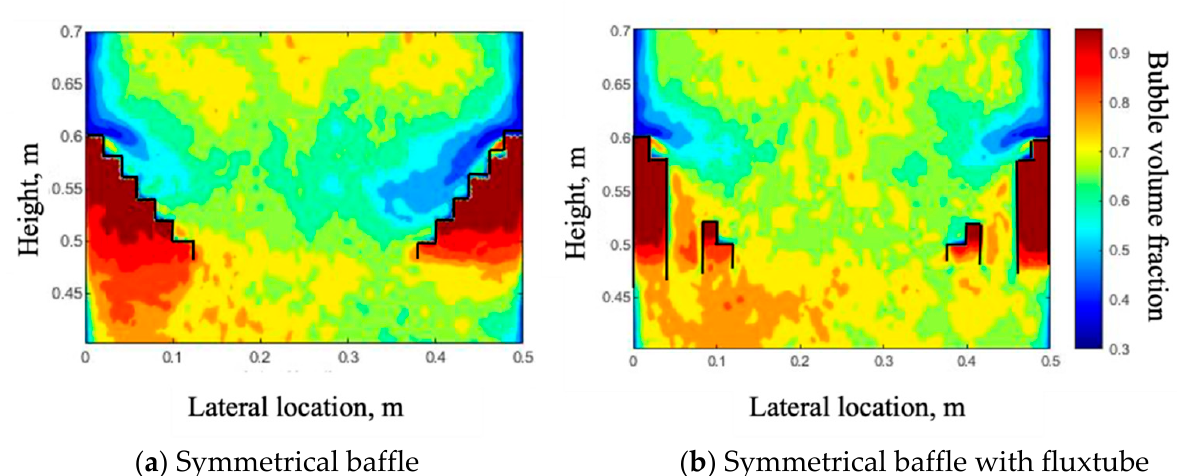
Figure 8. Radial gas bubble distribution profiles at injection level using the symmetrical baffle with and without the fluxtube under the superficial gas velocity of 0.4 m/s for the even gas inlet